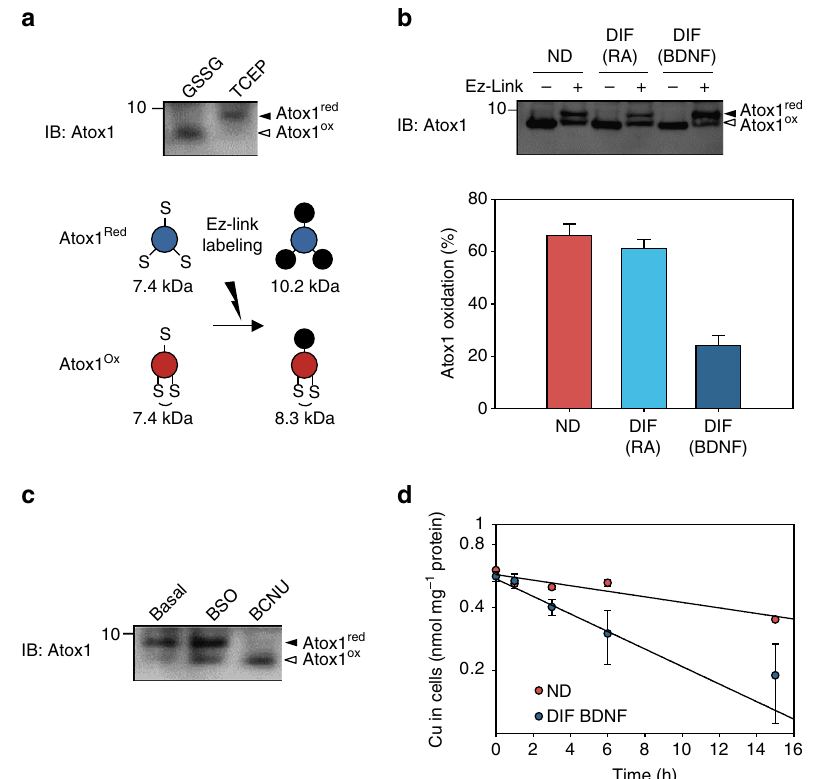
Figure 5 | The redox status and copper-binding ability of Atox1 are regulated by cytosolic glutathione and change during SH-SY5Ycell differentiation. ( a ) The approach for evaluation of the redox status of endogenous Atox1. The three cysteines (indicated by ‘S’) present in Atox1 (protein mass ¼ 7.4kDa) are labelled with Ez-Link (indicated by black circles, mass ¼ 922Da). The stoichiometry of labelling depends on the redox status. The upper panel shows the result of a control experiment where cell lysates were pretreated with either 1mM reducing reagent tris(2-carboxyethyl)phosphine or 1mM GSSG for 30min. Labelled proteins were separated on 15% Tricine gel. The higher and lower bands represent reduced and oxidized forms of Atox1, respectively. ( b ) Oxidation state of Atox1 changes with neuronal differentiation. Percentage of oxidized Atox1 was estimated by densitometry of bands. Three independent blots (Supplementary Fig. 16) were analysed and each value is presented as mean ± s.d. in the lower panel ( n ¼ 3). ( c ) The redox status of